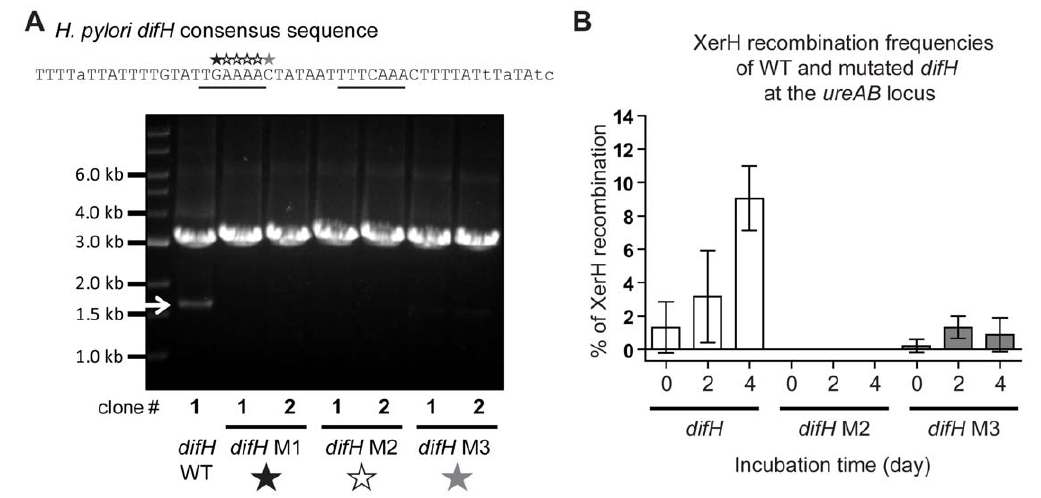
Figure 4. XerH-mediated recombination at mutant difH sequences. (A) The four A’s in positions 19 to 22 of the difH sequence were changed to T’s (empty stars), the G in position 18 was changed to C (black star) and the C in position 23 was changed to G (grey star). PCR tests were carried out as in Figure 1 on a clone harbouring WT difH repeats and two clones harbouring each mutant difH sequence (same sequence in each copy of difH ) as indicated by the stars, difH M1, difH M2 and difH M3. No PCR product reflecting difH recombination was detected in difH M1, difH M2 mutants, whereas a weak band reflecting difH recombination was detected in the two clones with difH M3 sequences. Underlined nucleotides were found in a palindrome in all species studied. (B) difH recombination frequencies for WT difH and the difH M1, difH M2 and difH M3 mutant sequences carried out as in Figure 2B. Experiments were performed in triplicate; horizontal bars indicate means and standard deviations.